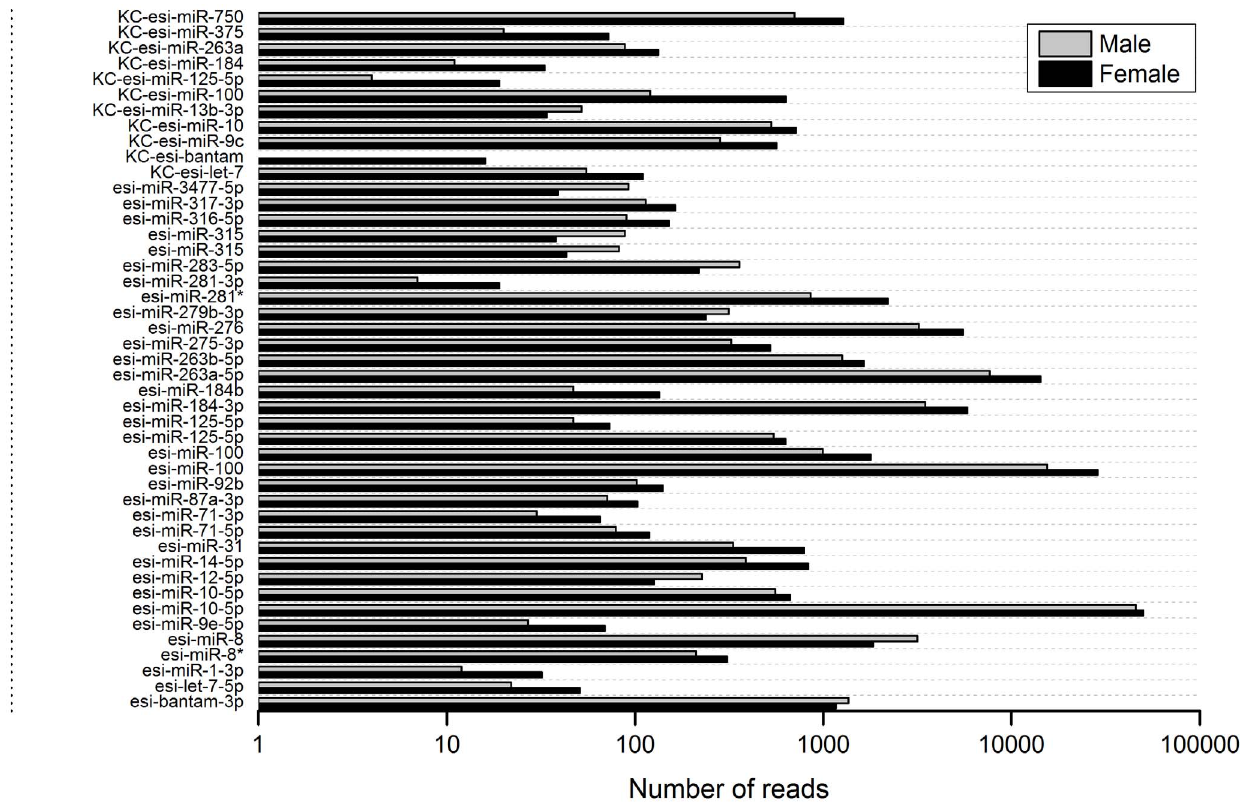
Figure 5. Comparison of the differentially co-expressed miRNAs between the female and male E.sinensis . 45 miRNAs showed significant differential expression between the female (black) and male (light gray) libraries (p-value , 0.0001). The frequency of miRNAs in two libraries were normalized.